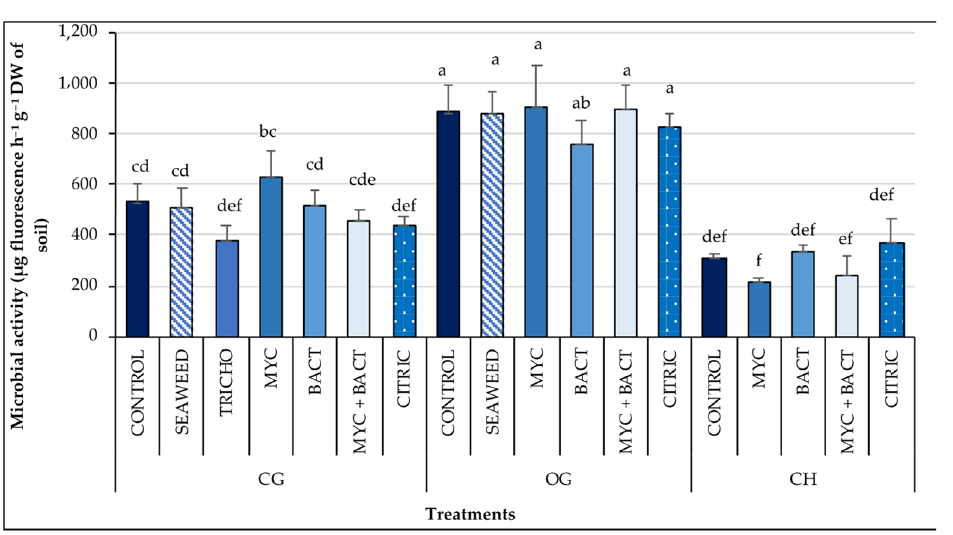
Figure 1. Influence of the studied biostimulants and growing systems on the microbial activity of the soil during winter and summer 2018. Means followed by the same letter are not significantly different ( p ≤ 0.05). Microbial activity is expressed in μ g fluorescence h − 1 g − 1 dry weight of soil. CG: conventional greenhouse; OG: organic greenhouse; CH: conventional high tunnel; CONTROL: without biostimulant; SEAWEED: seaweed extract; TRICHO: Trichoderma , MYC: mycorrhiza ( Rhizoglomus irregulare ); BACT: three bacteria ( Azospirillum brasilense , Gluconacetobacter diazotrophicus , and Bacillus amyloliquefaciens ); MYC + BACT: a combination of treatments MYC and BACT; CITRIC: Citric acid. Table 1. Influence of biostimulant treatments on chlorophyll fluorescence parameters, Fv/Fm and performance index (PI), and leaf chlorophyll content (SPAD) of strawberries grown conventionally and organically under a greenhouse and high tunnel during winter and summer